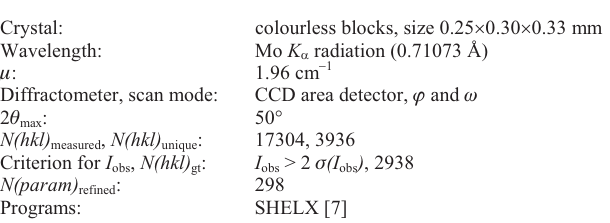
Table 1. Data collection and handling.